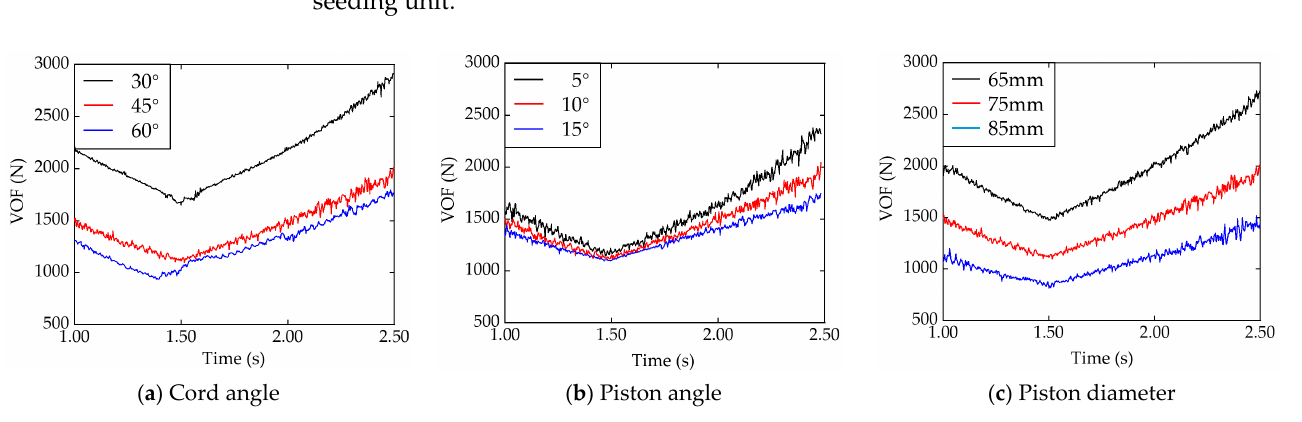
Figure 9. The fitting curve of VOF and VS.